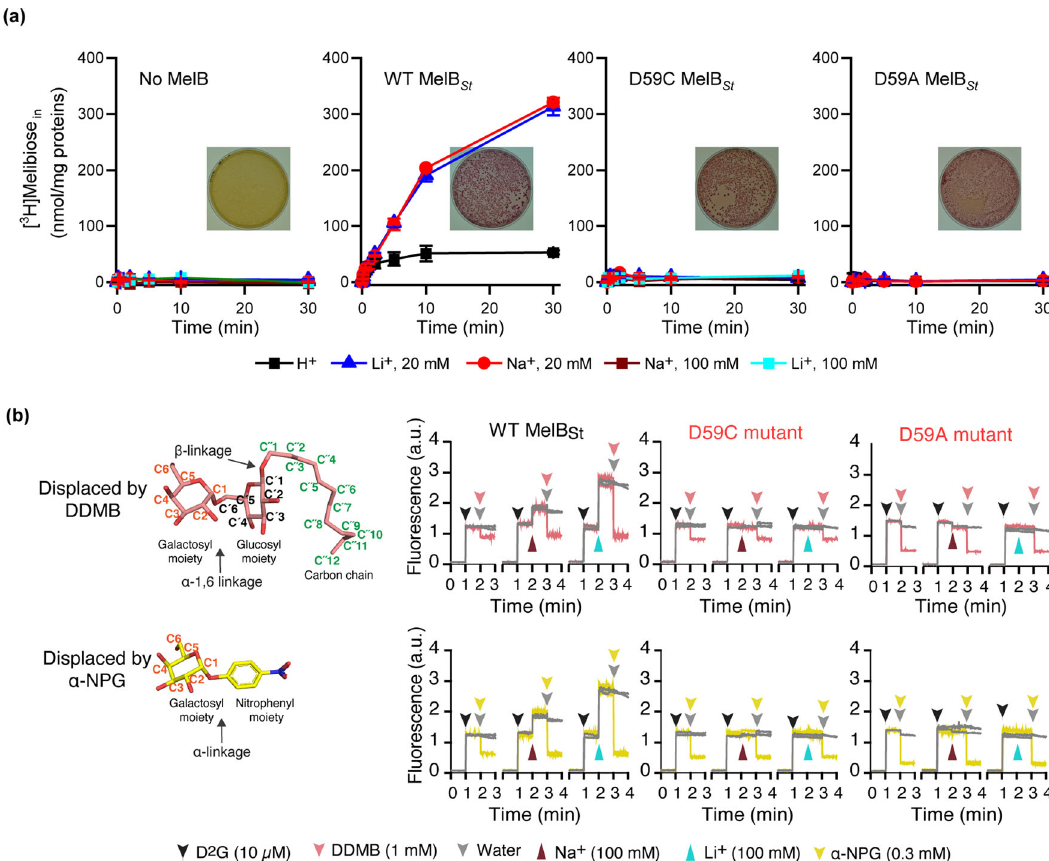
Fig. 1 Functional characterizations. a [ 3 H] Melibiose transport time course with intact cells. E. coli DW2 strain ( melB − , lacZ − Y − ) expressed with the WT, D59C, or D59A MelB St mutants were subjected to [ 3 H]melibiose active transport assay at 0.4 mM and 10 mCi/mmol in the presence of 20 mM or 100 mM NaCl or LiCl by a fast fi ltration method. Inset, melibiose fermentation assay. Transformants with DW2 strain were plated on MacConkey agar plates containing 30 mM melibiose as the sole carbohydrate source and pH sensor neutral red, and incubated at 37 °C for 16 – 18 h before imaging. Number of tests = 3, from different batch of cells or duplicate measurements from same batch of sample. b Ligand binding by Trp → dansyl galactoside (D 2 G) FRET assay. Puri fi ed proteins at 1 μ M concentration in 20 mM Tris-HCl, pH 7.5, 100 mM CholCl, 10% glycerol, and 0.03% UDM were subjected to steady-state fl uorescence measurements as described in Methods. On the time-trace, 1.8 μ L of 1 mM D 2 G at 10 μ M was added into 180 μ L of protein solutions at 1-min point, followed by supplying 10 μ L of 5 mM DDMB or 5 mM α -NPG to displace the bound D 2 G. For testing Na + or Li + binding, they are added into the solution before displacement with the second sugar. The structure of DDMB or α -NPG is shown in a chair form, and the carbon positions are labeled. Glycosidic bonds are indicated by arrows. Both are α -galactosides containing a substituent at the anomeric carbon-1. The data were from duplicate measurements.